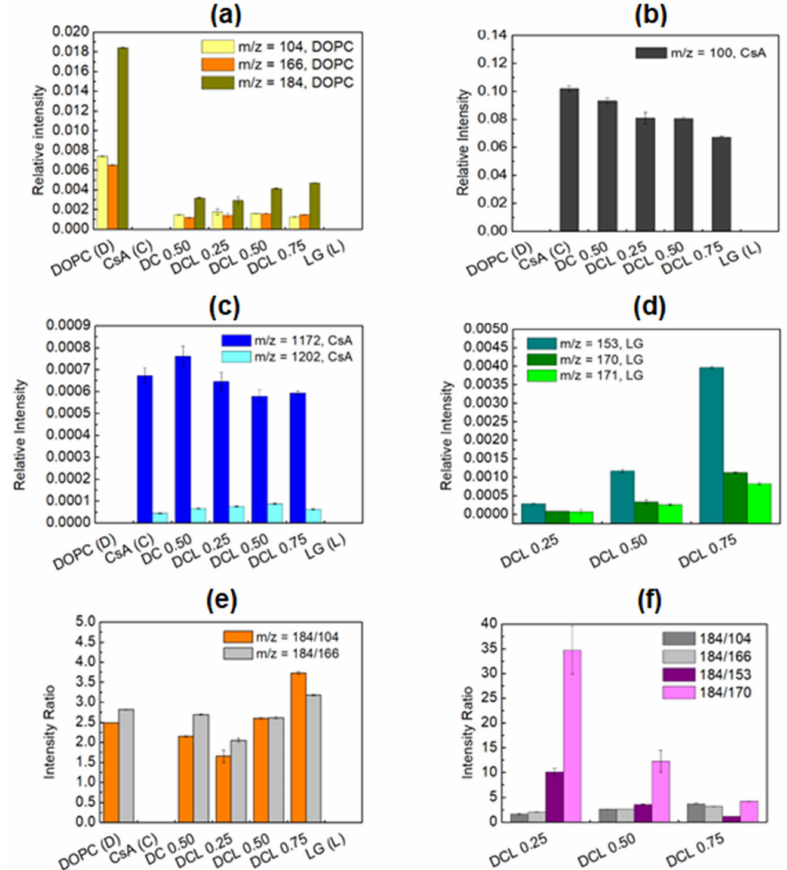
Figure 5. Distribution of 1,2-dioleoyl- sn -glycero-3-phosphocholine m / z = 104, 166, and 184 (phospho- choline) fragments ( a ), cyclosporine m / z = 100 fragment ( b ), cyclosporine m / z = 1172, 1202 fragments ( c ), lauryl gallate m / z = 153, 170, 171 fragments ( d ), intensity ratio of DOPC to DOPC fragments ( e ) intensity ratio of DOPC to DOPC and DOPC to LG fragments ( f ) in single, binary, and ternary monolayers deposited onto PET air